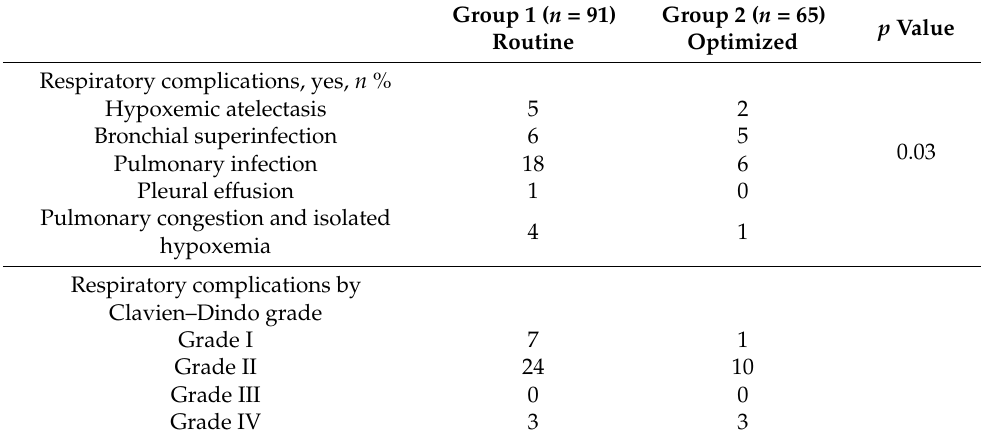
Table 4. Postoperative pulmonary